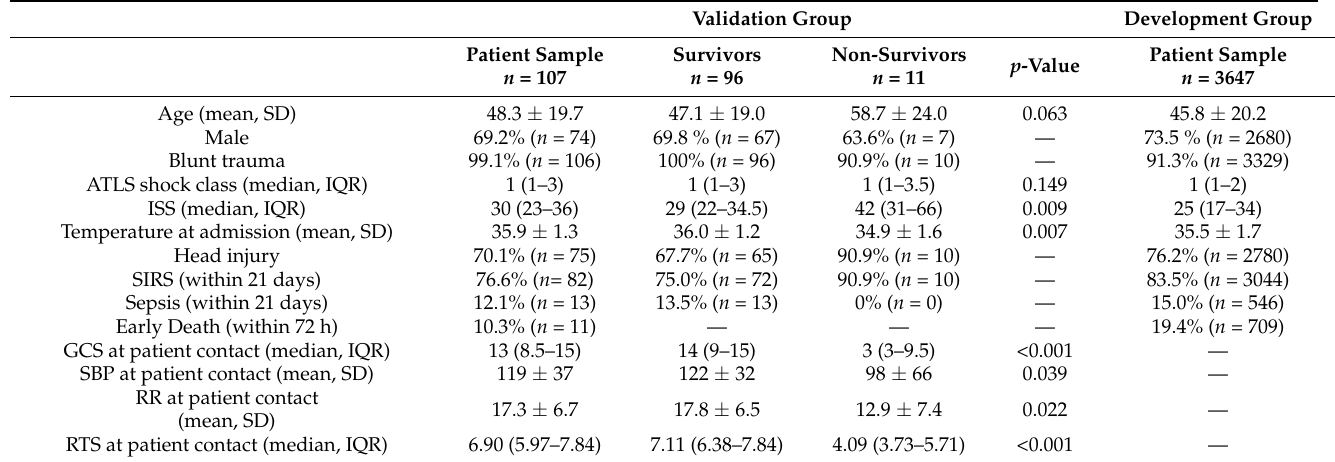
Table 2. General characteristics of the validation group and the development group.